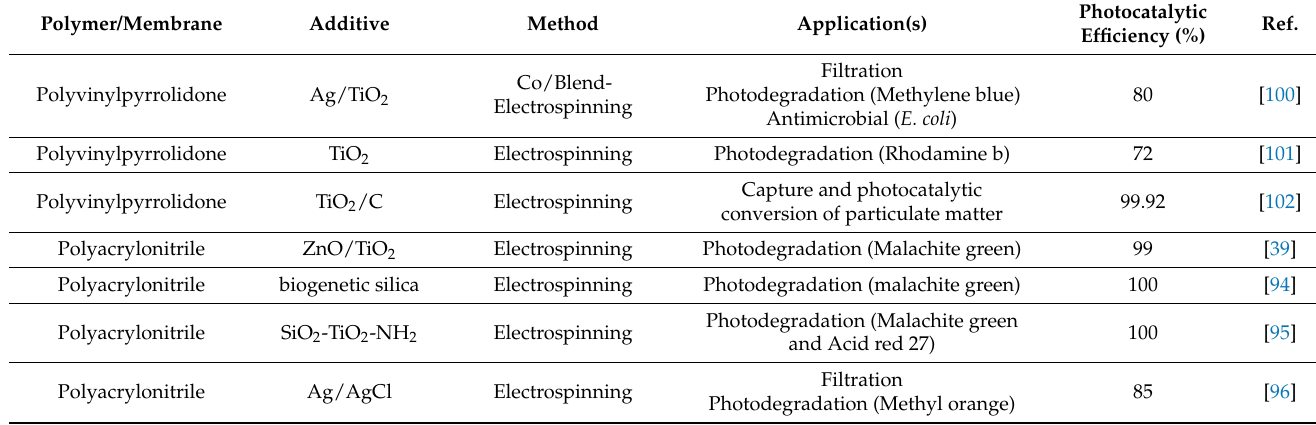
Table 2. Photocatalytic nanofiber membranes, their preparation methods, and applications. Polymer/Membrane